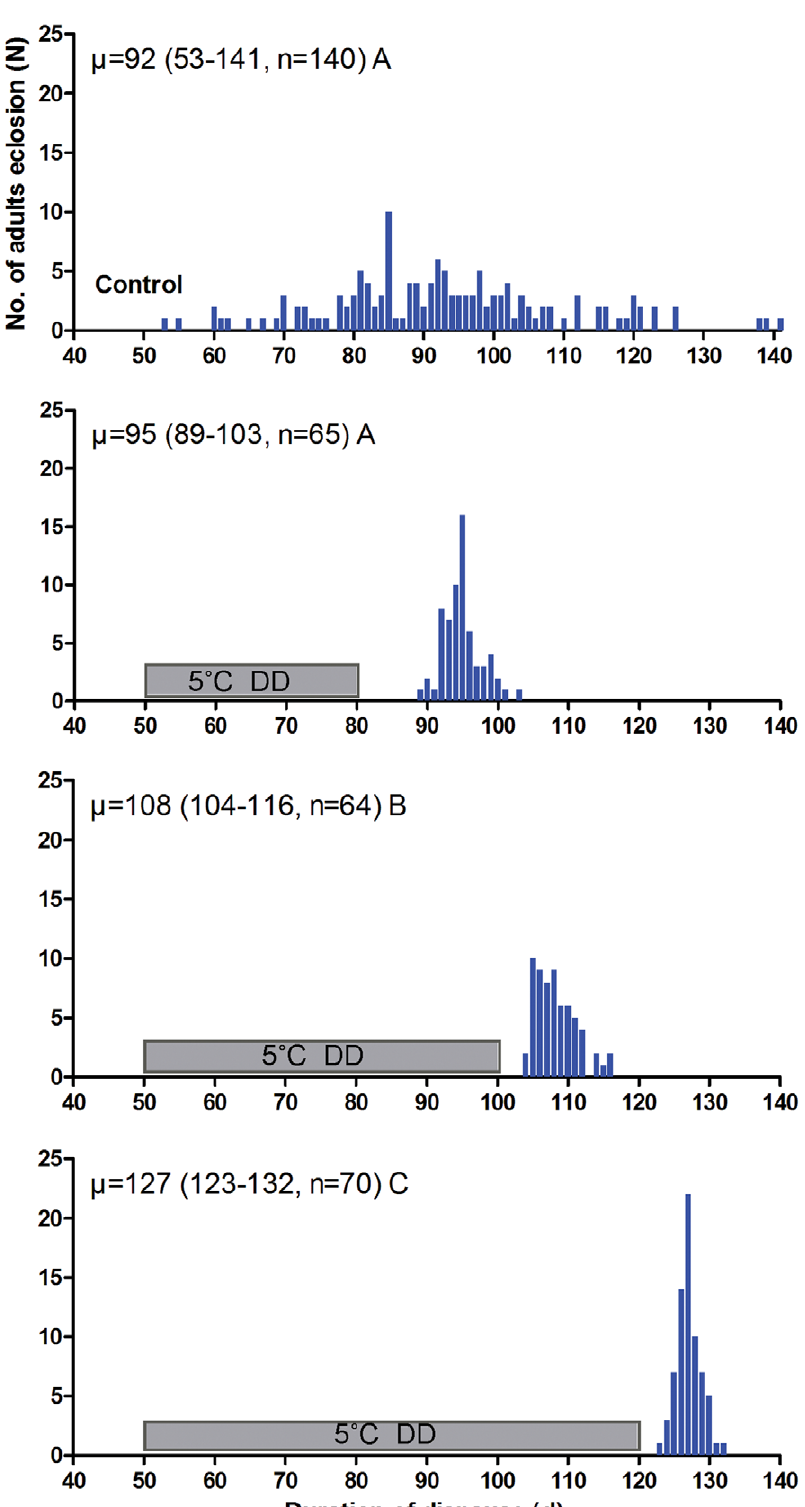
Figure 2. Frequency distribution of adult eclosion in summer diapausing pupae of P.melete. The summer diapausing pupae were transferred to LD12.5:11.5 at 20 u C after exposure to 5 u C and DD for different days. The hatched bar indicates the period of cold exposure. Values followed by different letters are significantly different by Kruskal-Wallis test and Bonferroni multiple comparison ( x 2 =224.312, d.f.=3, P =0.0001 , 0.01).